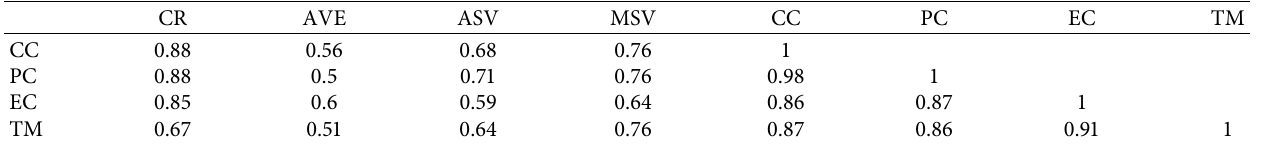
Table 3: Validation measures for the four-factor model.